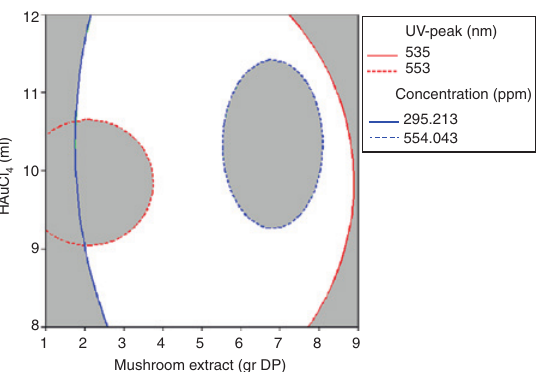
Figure 4: Surface plot (A) and contour plot (B) for concentration of synthesized AuNPs as function of MEC (g/100 ml) and amount of HAuCl (ml). 4